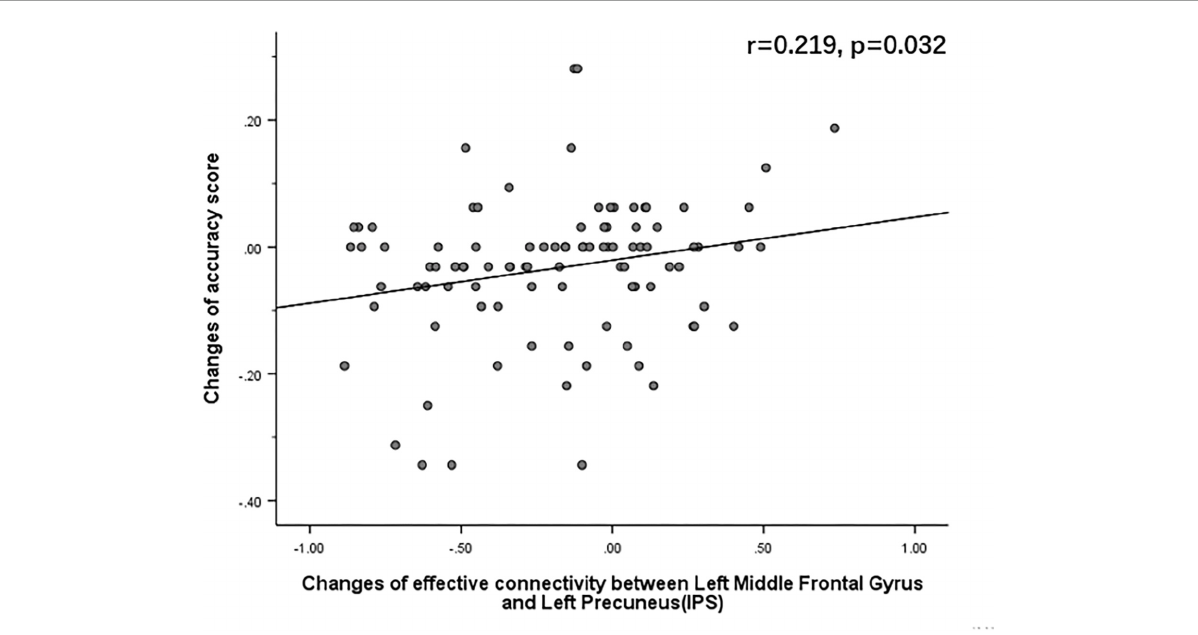
FIGURE9 After sleep deprivation, there was a positive correlation, under the identical condition, between the change in effective connectivity from the left middle frontal gyrus to the left inferior parietal lobule ( t 95 = 4.627, p < 0.004) and change in accuracy ( r = 0.242, p = 0.017).